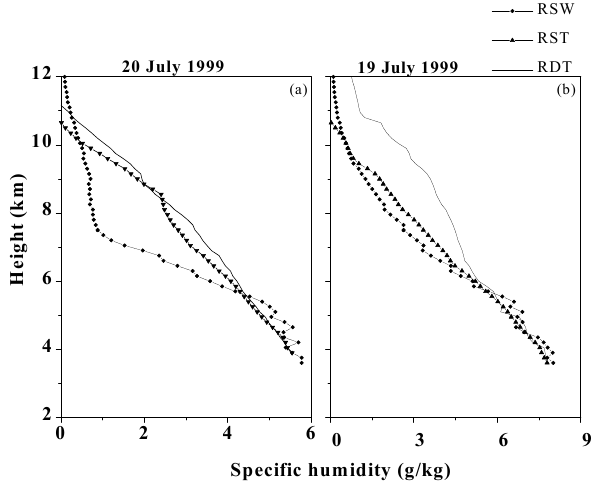
Fig. 5. Comparison of radar derived humidity profiles using radar derived temperature (RDT) and radiosonde measured temperature (RST) profiles with the humidity as measured by radio sonde (RSW) on (a) on a clear day (20 July 1999) and (b) on a cloudy day (19 July